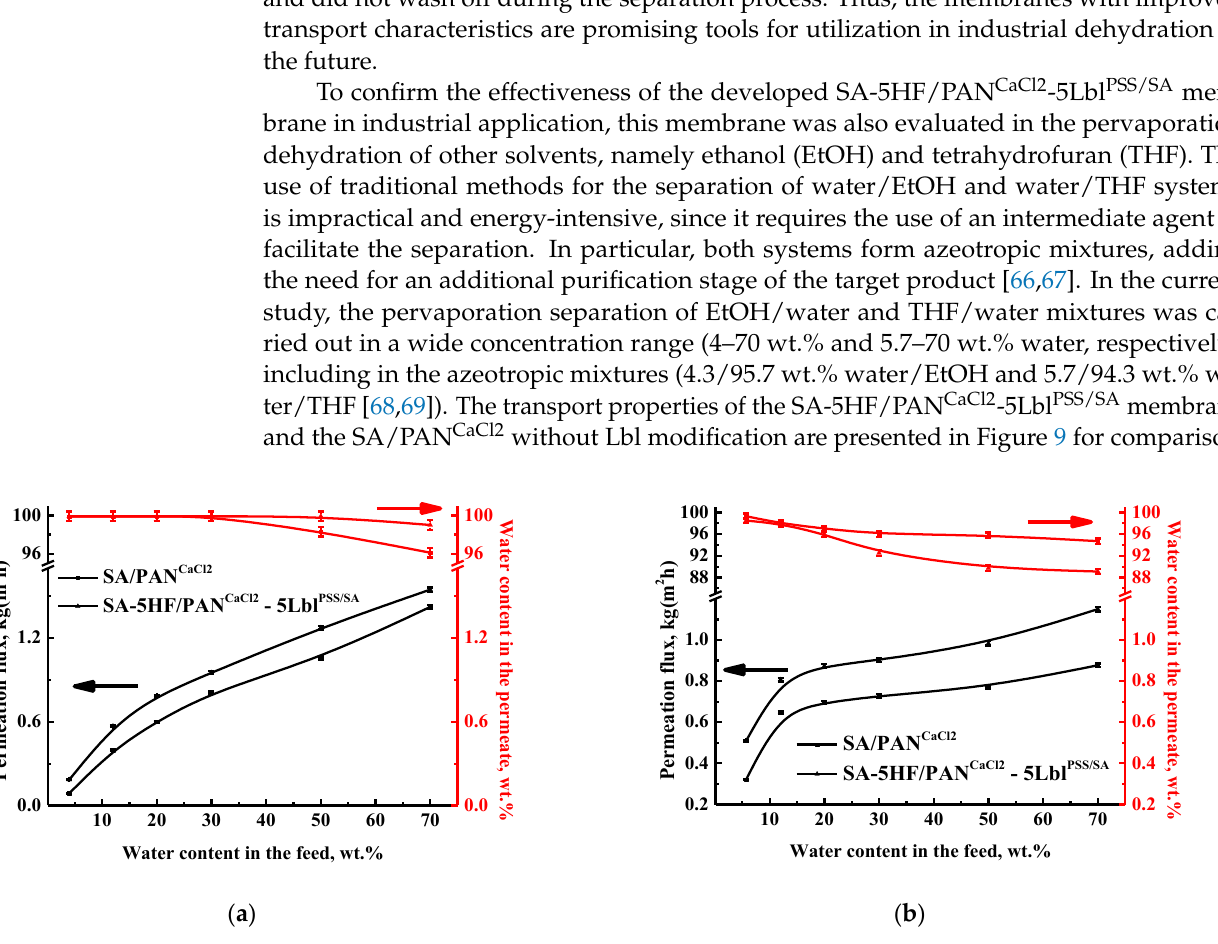
Figure 9. The dependence of the permeation flux and water content in the permeate on the water content in the feed for the SA-5HF/PAN CaCl2 -5Lbl PSS/SA and SA/PAN CaCl2 membranes in the pervaporation dehydration of ( a ) ethanol (4–70 wt.% water) and ( b ) THF (5.7–70 wt.% water) at 22 °C.